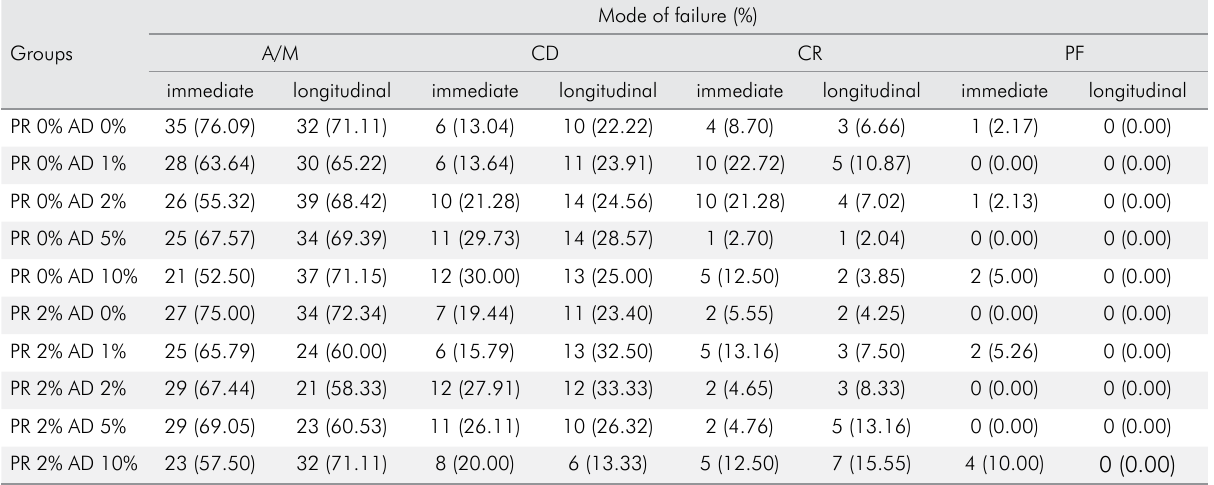
Table 3. Mode of failure distribution (in percent, %) for immediate and longitudinal microtensile bond strength specimens. Groups immediate longitudinal immediate longitudinal immediate longitudinal immediate